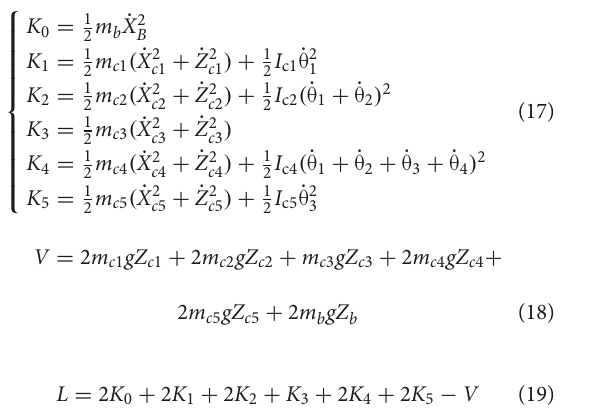
center of mass of each rod. The jumping action of the robot is analyzed on the XOZ plane of the base coordinate system. The rotation axis of the rod is the Z axis of the corresponding joint coordinate system. In order to simplify the calculation of the inertia tensor, let the coordinate system with the center of mass of each rod as the origin of the inertia tensor coincide with the three inertia axes of the rod, and according to the parallel shift axis theorem, the change of the rotation axis of the connecting rod only changes the size of the moment of inertia in the inertia tensor, so the inertia tensor can be easily calculated using Adams